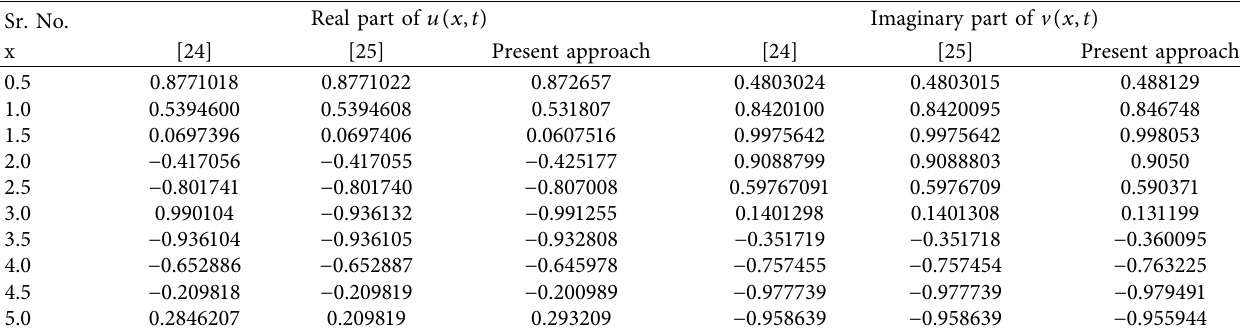
Table 2: Two-scale results for u ( x,t ) and v ( x,t ) with μ � η � 1 and t � 0 . 01 when α � 1. Sr.